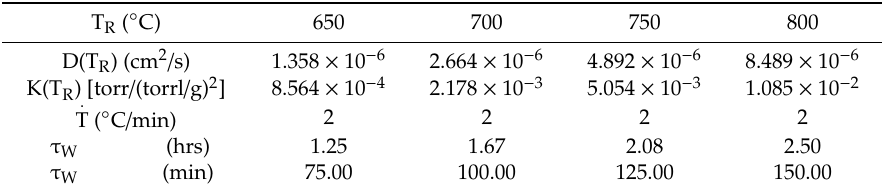
Table 5. Di ff usivity, Sieverts’ constant and warm up τ W of ST101 for di ff erent values of the regeneration temperature T R